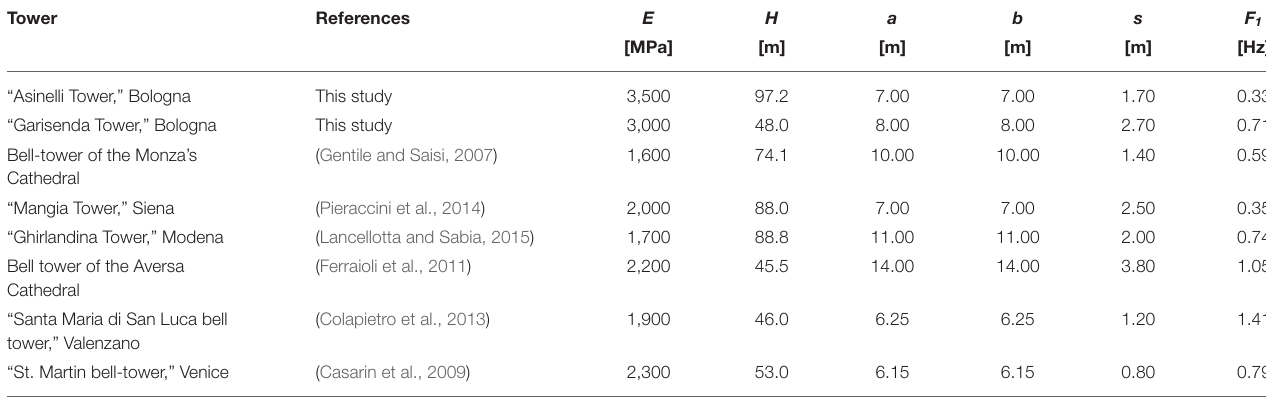
TABLE 4 | Experimental values of the fundamental frequency for selected masonry towers as available from the scientific literature.